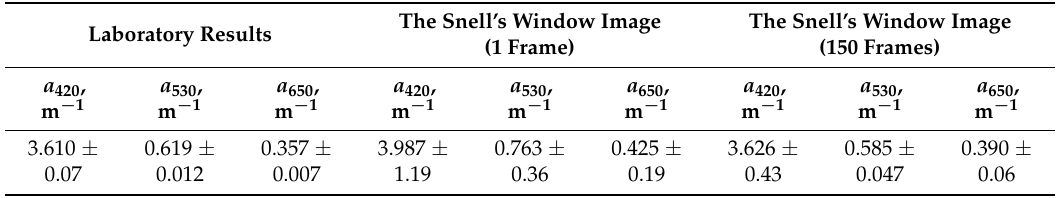
Table 5. The recovery results of the absorption coefficient of the Gorky Reservoir from the Snell’s window images in comparison with related